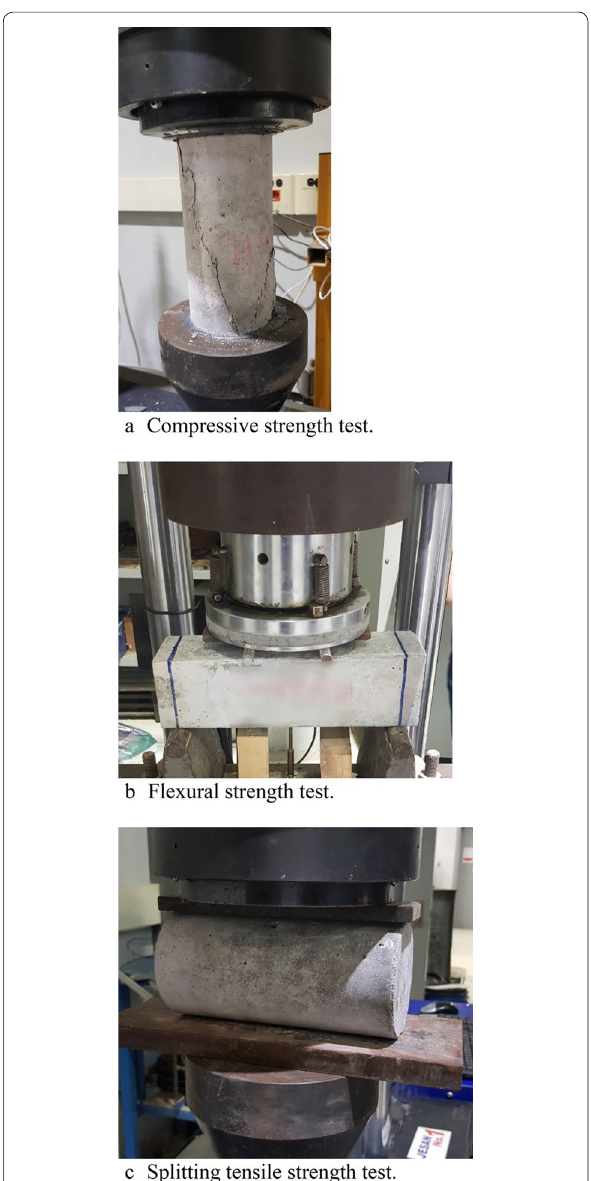
Fig. 6 Views of different test